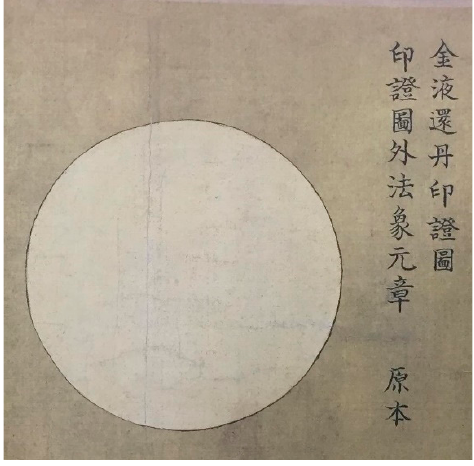
Figure 12. Diagram of yuanben in Jinye huandan yinzheng tu , colored scroll version.